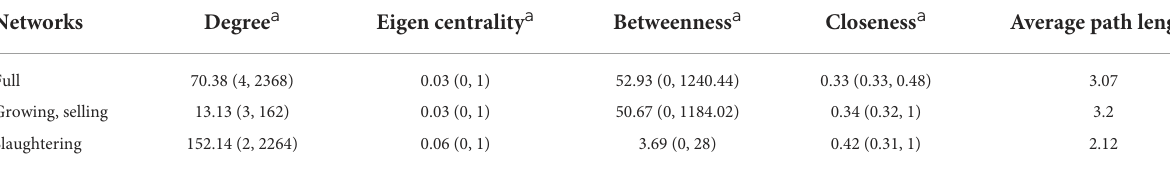
TABLE 9 District-level network metrics for the full network and networks stratified for the primary purpose of dairy cattle movement between districts in northern Thailand from 2010 to 2017. Networks